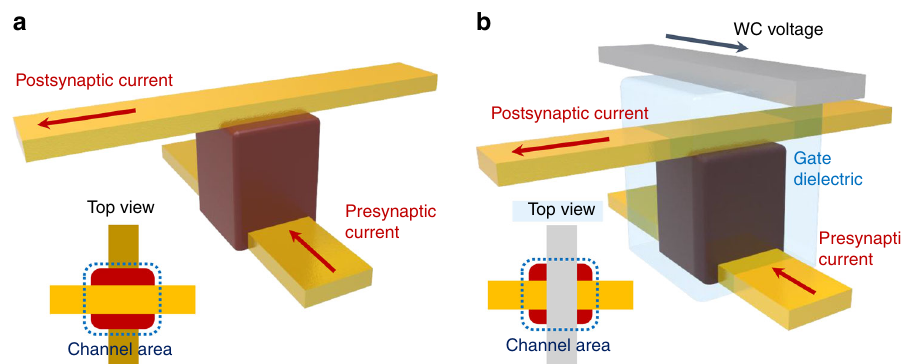
Fig. 1 Schematic illustration of synaptic devices. a Two-terminal synapse. b Three-terminal synapse with crossbar array structure.